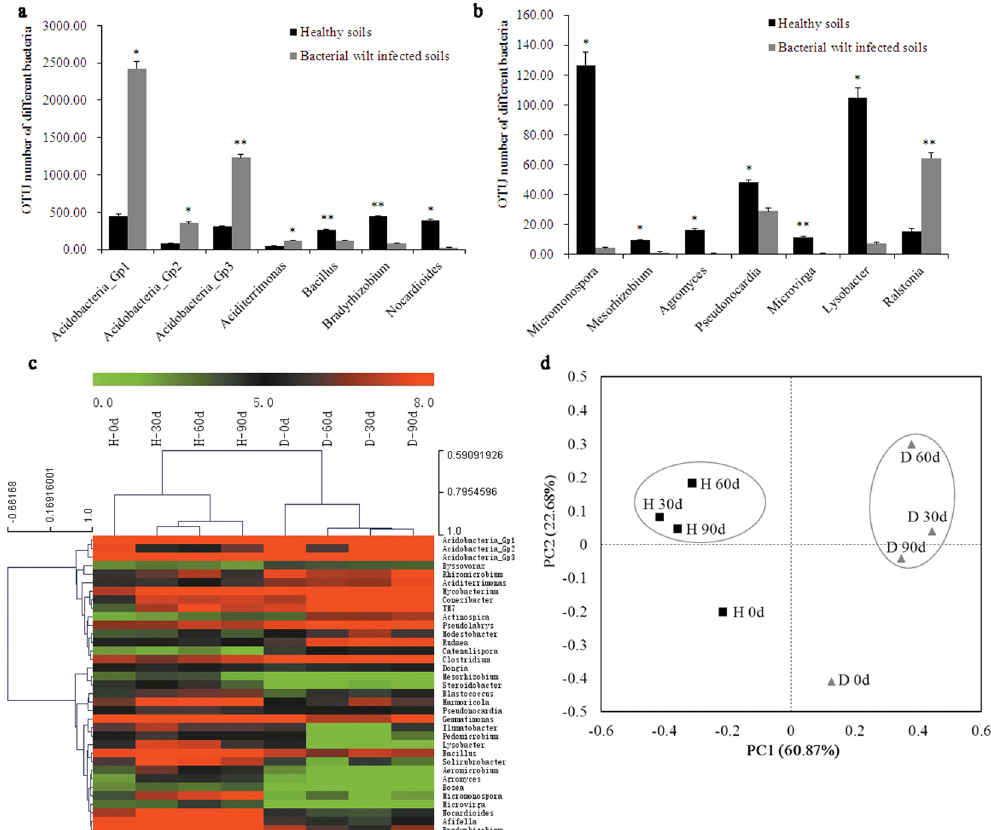
Figure 2. Comparison of abundance of different soil bacterial genera and bacterial community between healthy and bacterial wilt infected soils. ( a ) and ( b ) Abundances of different soil bacterial genera were compared between healthy and bacterial wilt infected soils; ( c ) Relative abundance and hierarchical cluster analysis of bacterial genera; ( d ) PCoA analysis of soil bacterial community. H: healthy soils; D: bacterial wilt infected soils. Bars with asterisk ( * ) and double asterisks ( ** ) indicate significant ( p < 0.05) and very significant ( p < 0.01) difference between healthy and bacterial wilt infected soils,